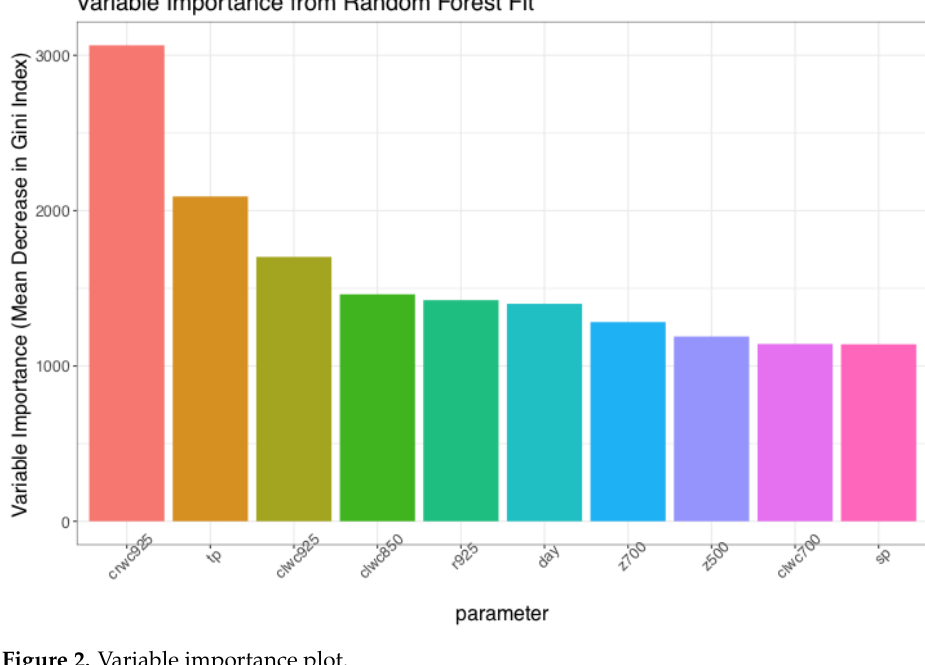
Figure 2. Variable importance